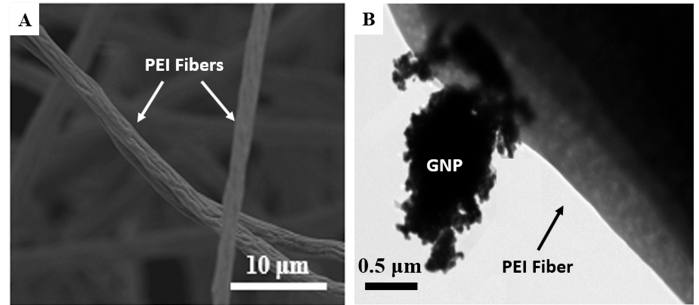
Figure 5. ( A ) Representative SEM image indicating the surface roughness of PEI electrospun fibers’ surface; ( B ) TEM image arose from PEI scaffold modified with 0.5 wt % GNPs, indicating the poor dispersibility of the nano-filler .